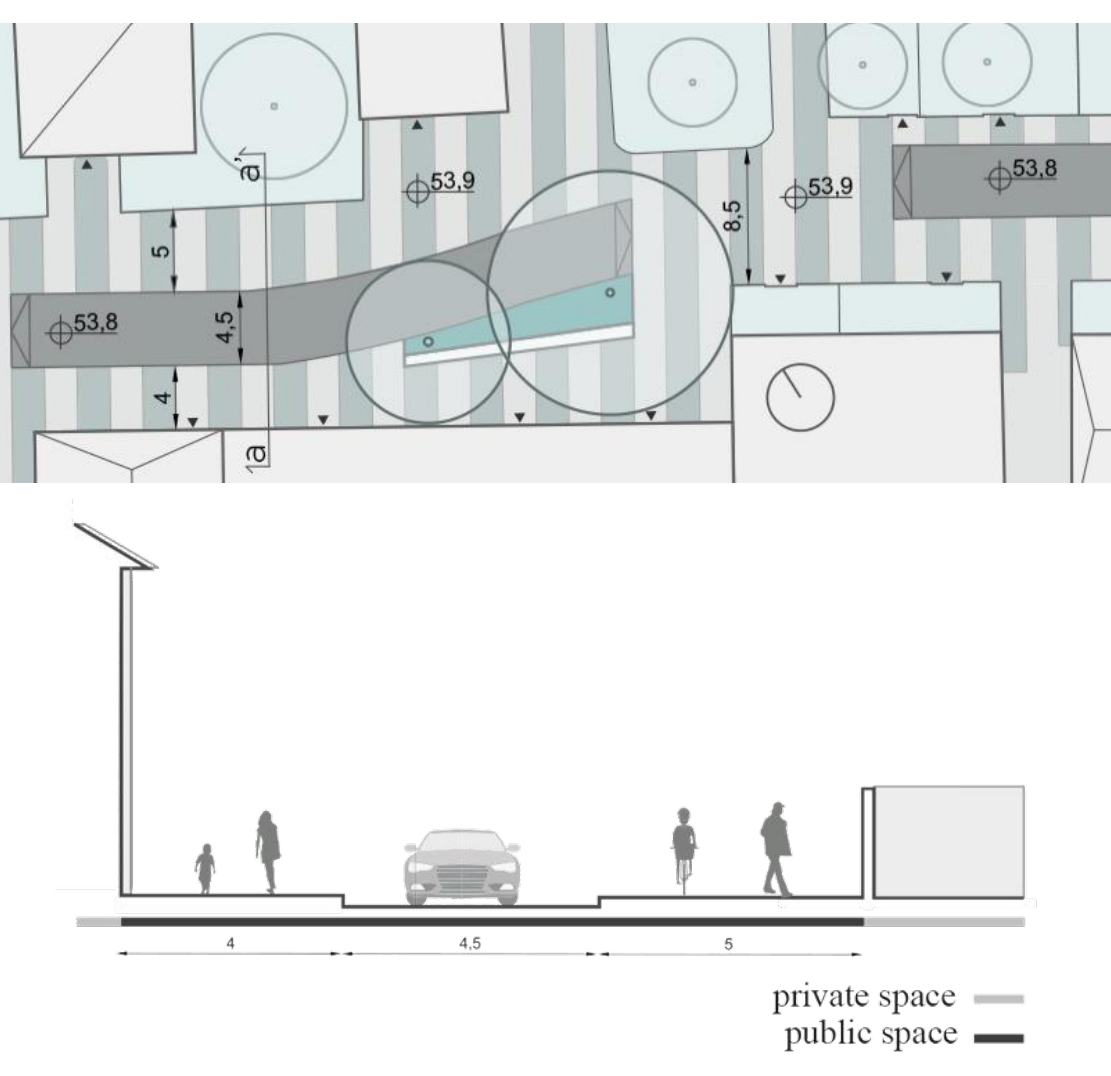
Figure 6 (a). Stretch 1, option 1: partial sharing; plan and section (a-a’) show a lack in vegetation and use